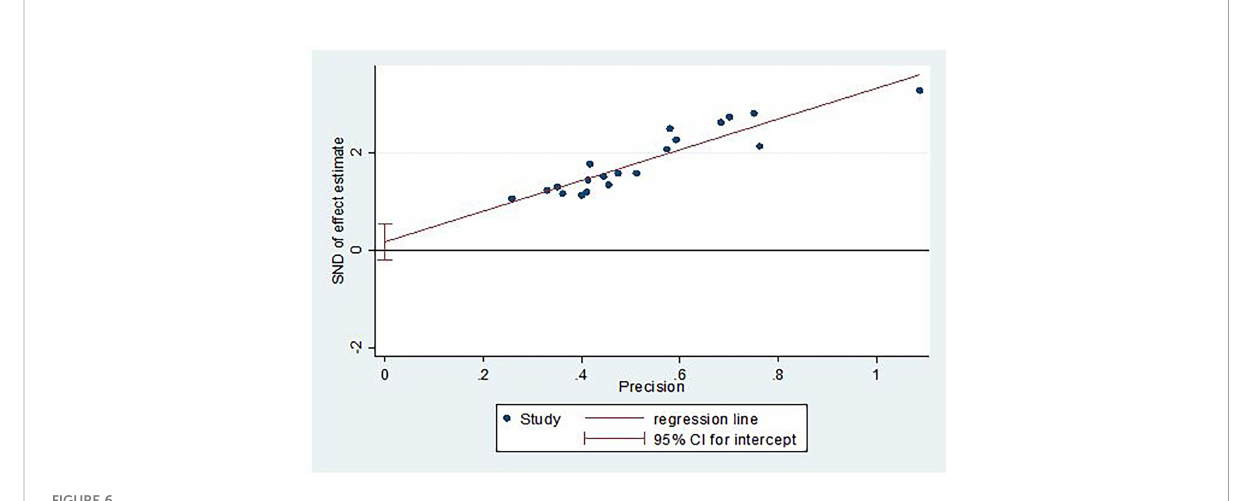
FIGURE 6 Egger test for small study